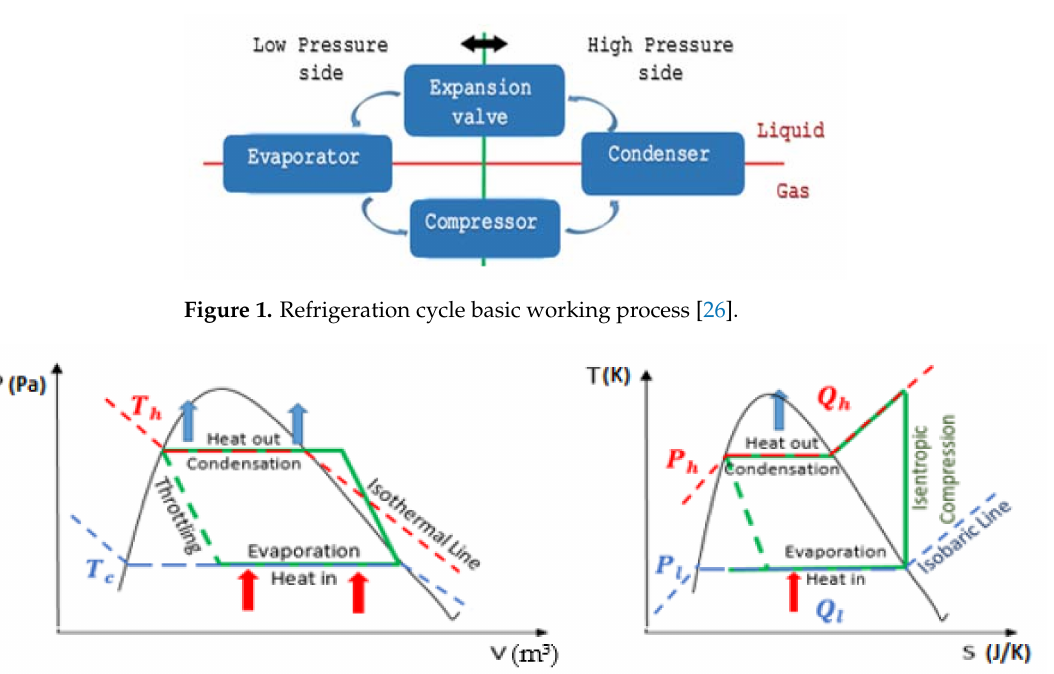
Figure 2. Change of state on P-V [27] and T-S [28]